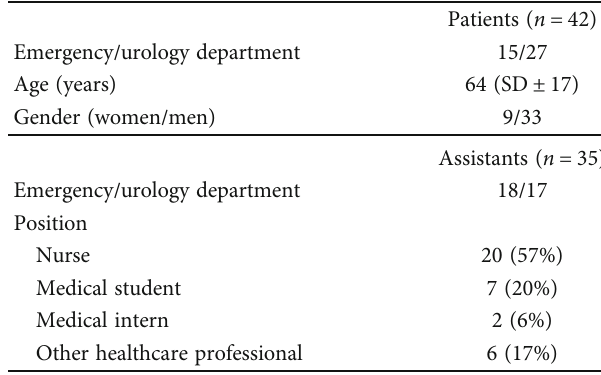
Table 1: Participant